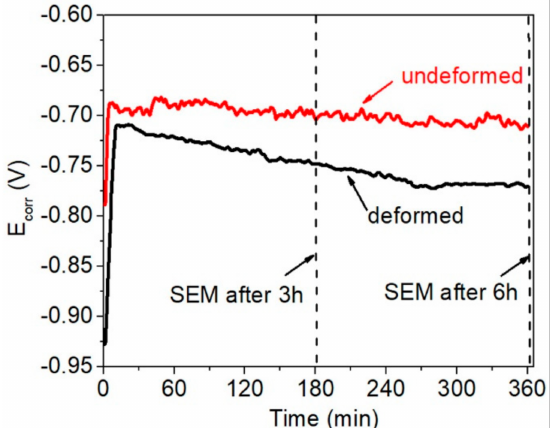
Figure 5. The E corr measurements recorded during 6 h of immersion in 0.5 M NaCl (pH 3) in the undeformed and deformed areas of AA5754. SEM observations were made after 3 and 6 h of immersion, as marked by the dashed lines.